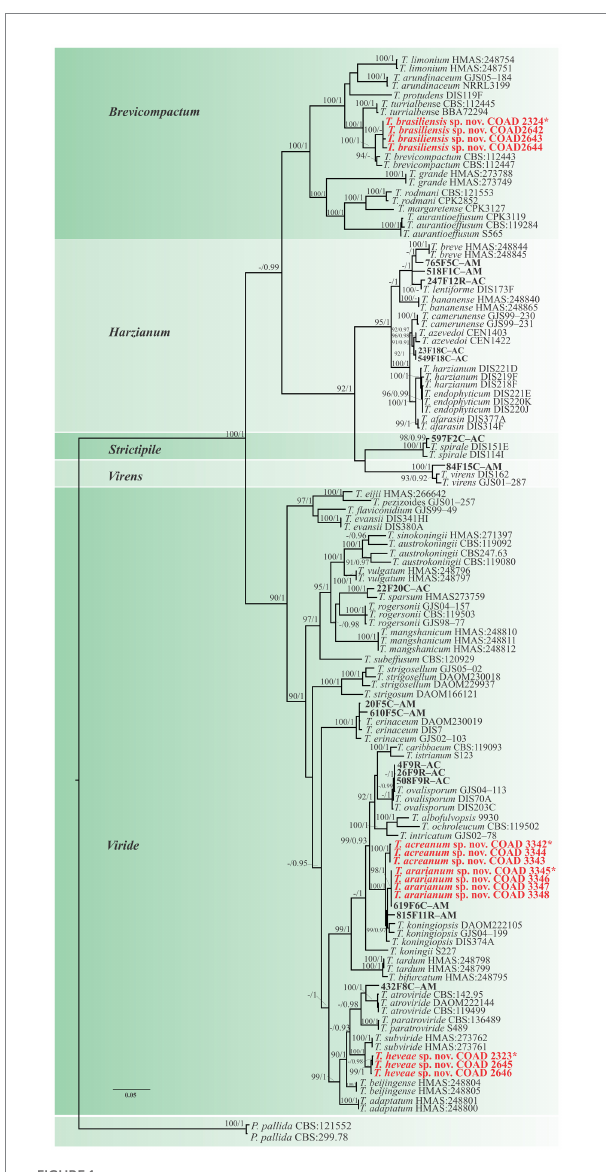
FIGURE 1 Phylogenetic tree of Trichoderma spp. based on combined RPB 2 and TEF1- α sequence datasets. Bootstrap values ( ≥ 70%) of the ML analyses, as well as posterior probability scores ( ≥ 0.95) from a BI of the same dataset, are indicated at well-supported nodes together with thickened branches. The scale bar represents the number of expected substitutions per site (0.05). The isolates belonging to known species obtained in this study are in bold red. Isolates of new species described in this study are in bold red. Holotype labeled with an asterisk. The tree is rooted in two isolates of Protocrea pallida (CBS:121552 and CBS:299.78). ”–” indicates a lack of